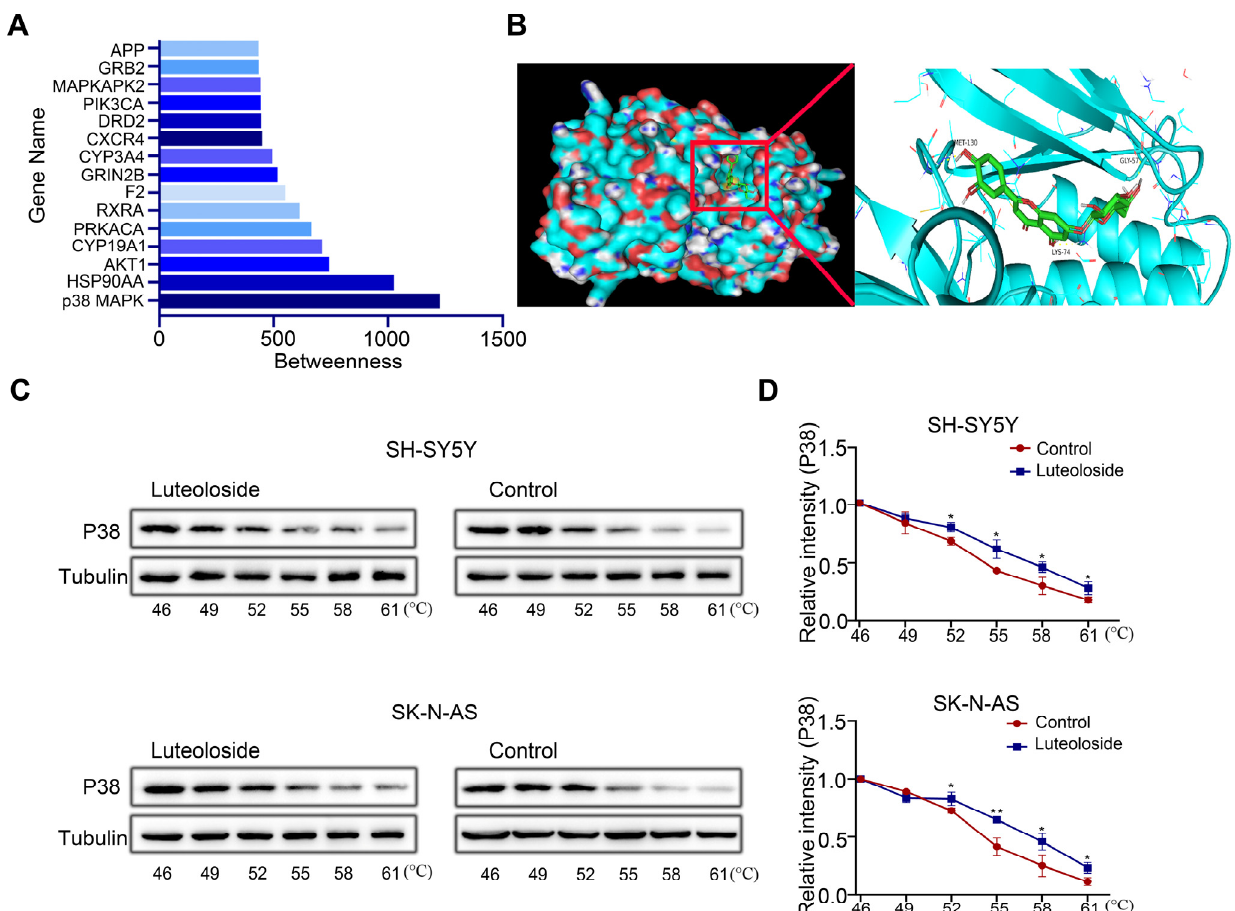
Figure 6. P38 MAPK was identified as a key target of luteoloside. ( A ) The top 15 luteoloside targets were visualized using Cytoscape. ( B ) The binding mode of luteoloside with p38 MAPK and the 3D illustration of the details of the interaction. Green shows luteoloside, aquamarine shows the protein of p38 MAPK. ( C ) The cellular thermal shift assay was used to evaluate luteoloside–p38 MAPK interactions in SH-SY5Y and SK-N-AS cells. ( D ) Quantification of the relative intensity of the p38 MAPK protein versus increased temperature. Tubulin is taken as internal reference. *, p < 0.05; **, p < 0.01. n = 3. The control group is used for comparison. Data are shown as mean ±